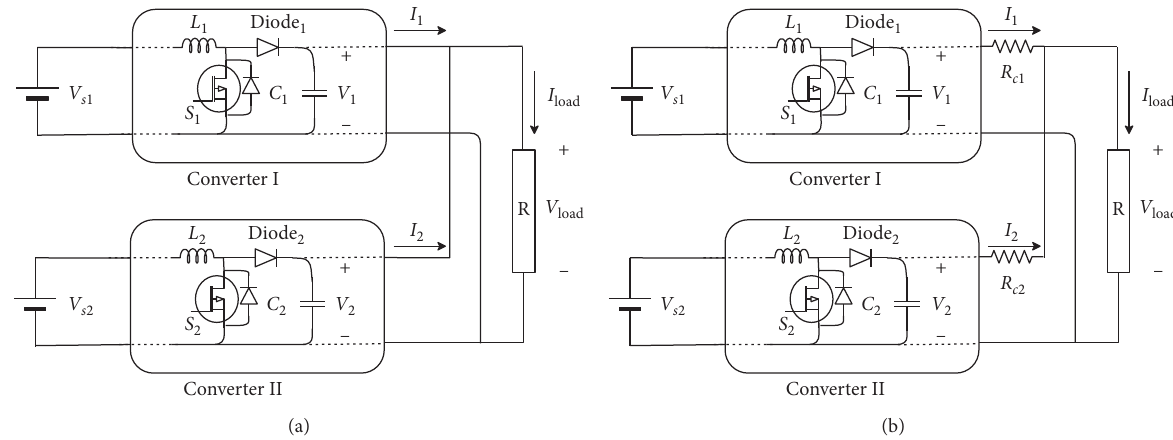
Figure 2: Circuit diagram of two parallel-connected boost converters to a resistive load. (a) Converters connected directly to a resistive load. (b) Converters connected to a resistive load through cable resistances.